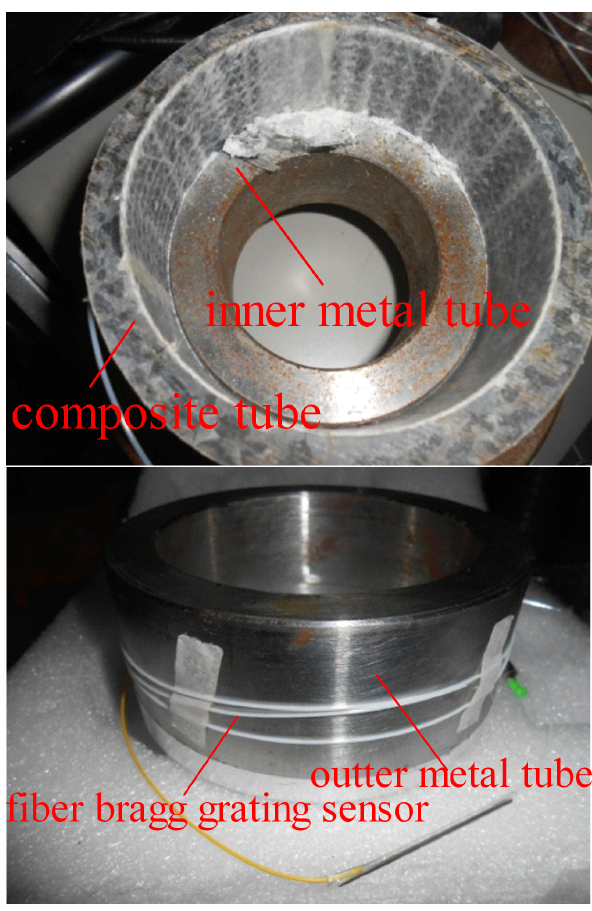
Figure 8: Measurements after the pushing process